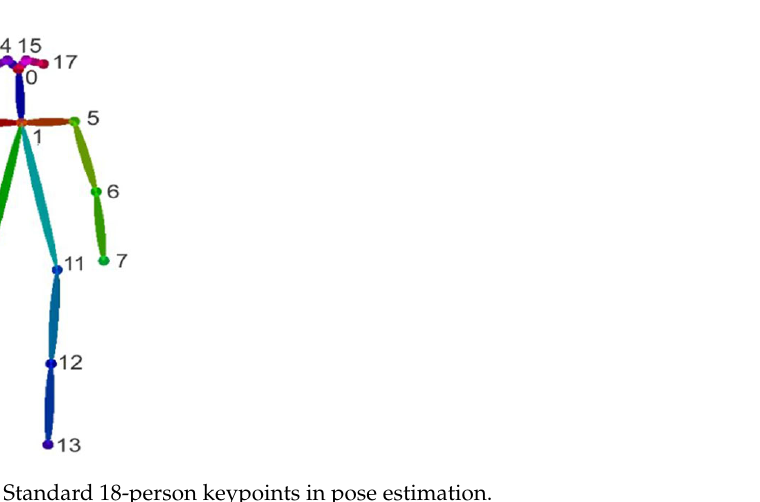
Figure 2. Standard 18 ‐ person keypoints in pose estimation.